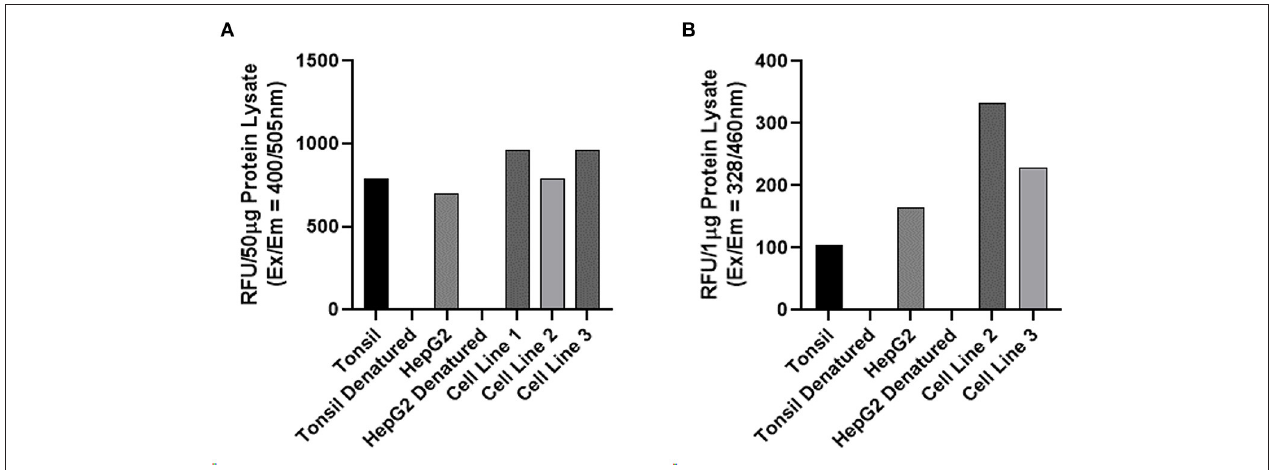
FIGURE 5 | Enzymatic activity assays of on three arterio-venous malformation-derived primary cell lines for cathepsin B and cathepsin D. Enzymatic activity assays demonstrating enzymatic activity of cathepsin B (A) and cathepsin D (B) with tonsil tissue and HepG2 cells as positive controls and denatured tonsil and denatured HepG2 cells as negative